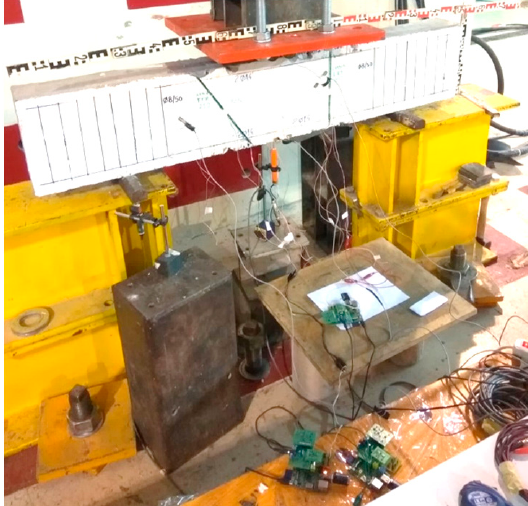
Figure 4. WiAMS devices of the proposed SHM method during the RC deep beam testing. The initial EMI measurements were carried out to the beam’s pristine condition, declared healthy, and used as a baseline state. Thence, the measurements were repeated at different potential damage states, the results were compared, and the structural integrity was evaluated through statistical indices (Figures 5 and 6).